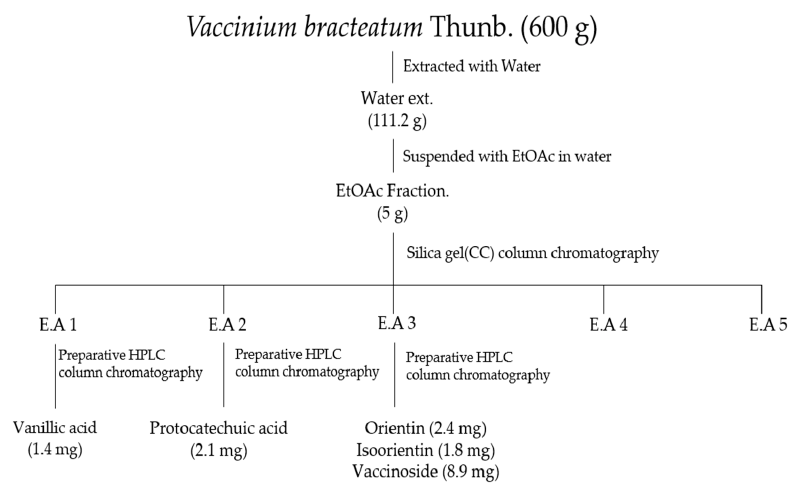
Figure 1. Fractionated process and isolated compounds 1–5 of aqueous leaf extract from Vaccinium bracteatum Thunb. in Korea.